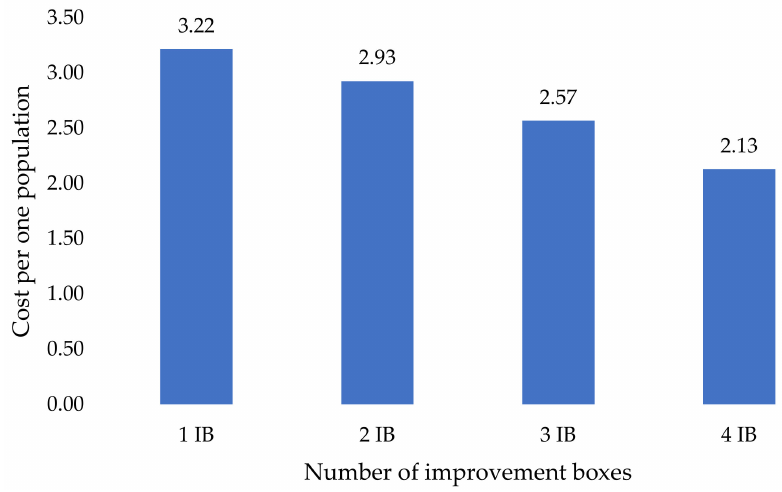
Figure 9. Average cost per population (baht/person).